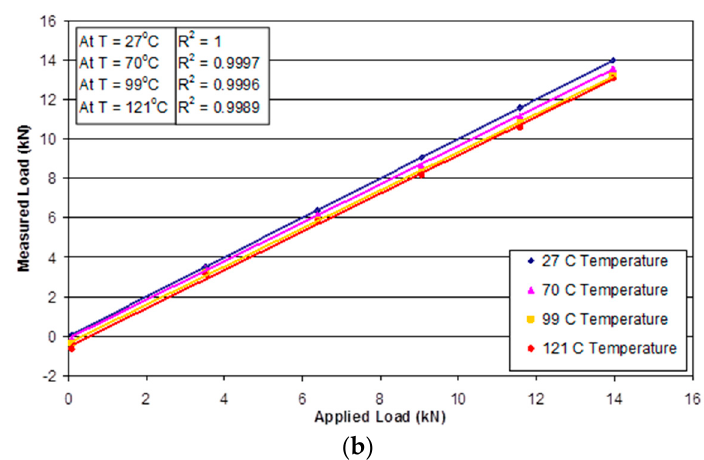
Figure 14. ( a ) Comparison of the load recorded by the load-cell (used on the pre-stressing rig) and the output from the pre-calibrated mechanical test machine; ( b ) Comparison of the load measured by the load-cell and the applied load via the mechanical test machine at specified temperatures.